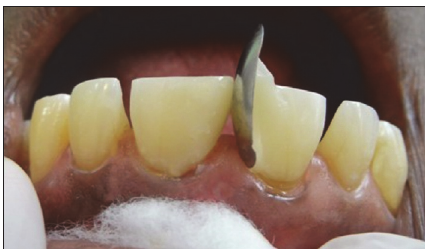
Figure 8: Finishing is done with an ET 9